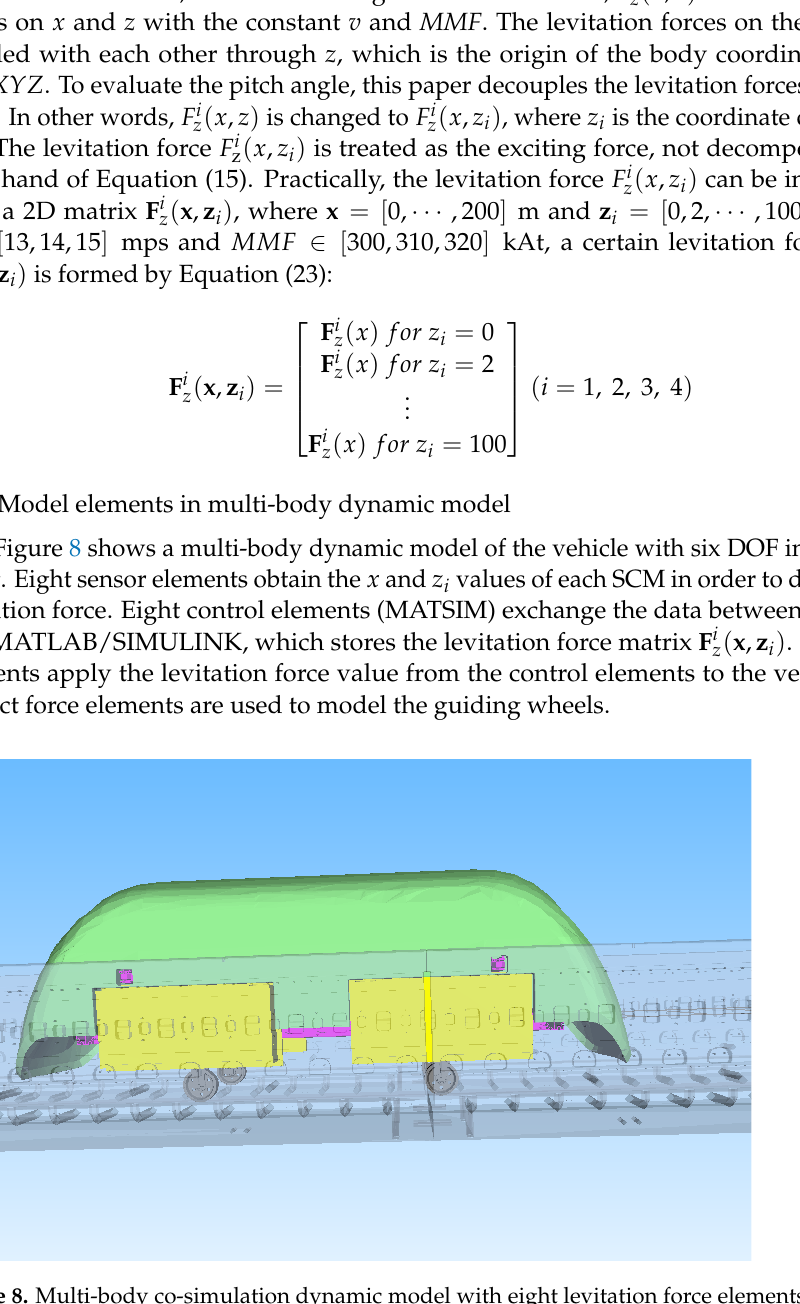
Figure 8. Multi-body co-simulation dynamic model with eight levitation force elements.